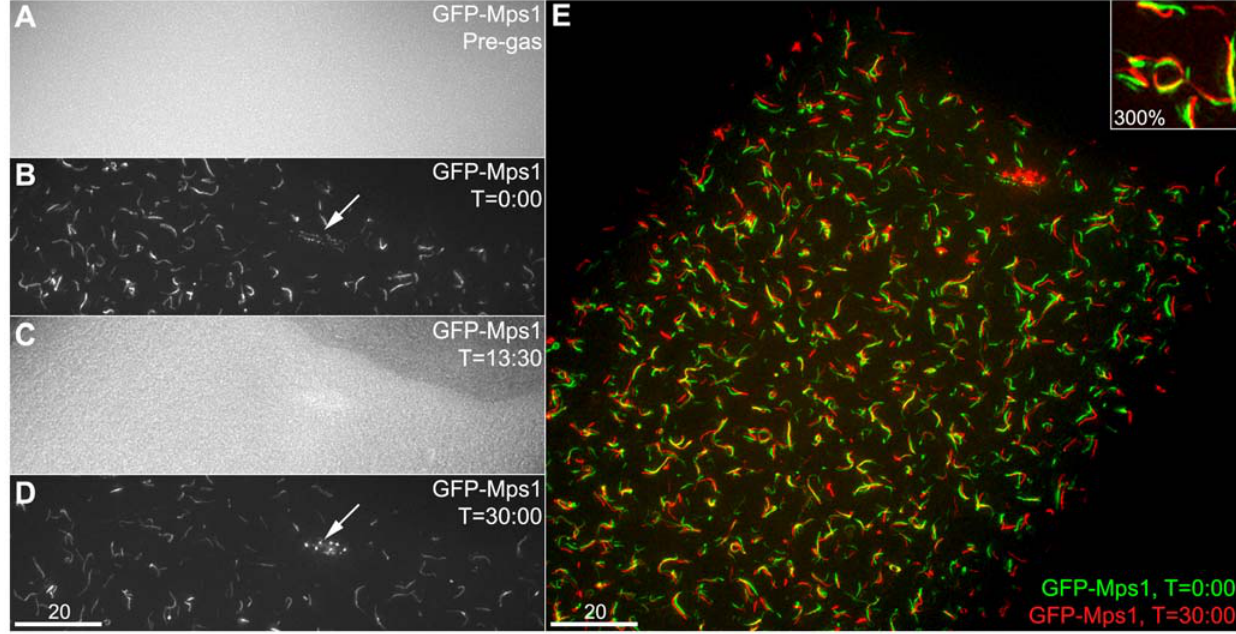
Figure 2. Hypoxia reversibly sequesters GFP-Mps1 to filaments. A live stage 13 GFP-Mps1 oocyte, positioned with the anterior end at the upper right and the posterior end towards the lower left, shows reversible sequestration of GFP-Mps1 to filaments under hypoxia. The entire cell was larger than the microscope’s field of view at this magnification. Five other oocytes on the same slide were monitored (but not imaged) at the 2A, 2B, and 2D time points; all exhibited similar localization of GFP-Mps1 to filaments. 2A: Prior to exposure to CO 2 , the oocyte does not exhibit GFP-Mps1 localization to filaments. 2B: After exposure to CO 2 , GFP-Mps1 shows localization to both ooplasmic filaments as well as small foci along the meiotic spindle (arrow). This image was acquired just prior to the 0:00 time point in Movie S1. 2C: After restoration of ambient air, the GFP has diffused back into the ooplasm and the filaments are no longer visible. This image is the 13:30 frame of Movie S1. 2D: After reintroduction of CO 2 , GFP-Mps1 localization to filaments and the spindle has reappeared. Note that now the spindle localization (arrow) is in closely arranged bright foci, corresponding to the kinetochores of the meiotic chromosomes. This image was acquired just after the 30:00 time point in Movie S1. 2E: The before and after images from 2B and 2D are superimposed on each other as green (before) and red (after), respectively. This image shows that the cell has flattened out slightly, as the lateral width across the cell has increased, and some filaments have moved slightly. However, most of the filaments have reappeared with the same topology and in roughly the same locations (300% enlargement of area near center, inset).